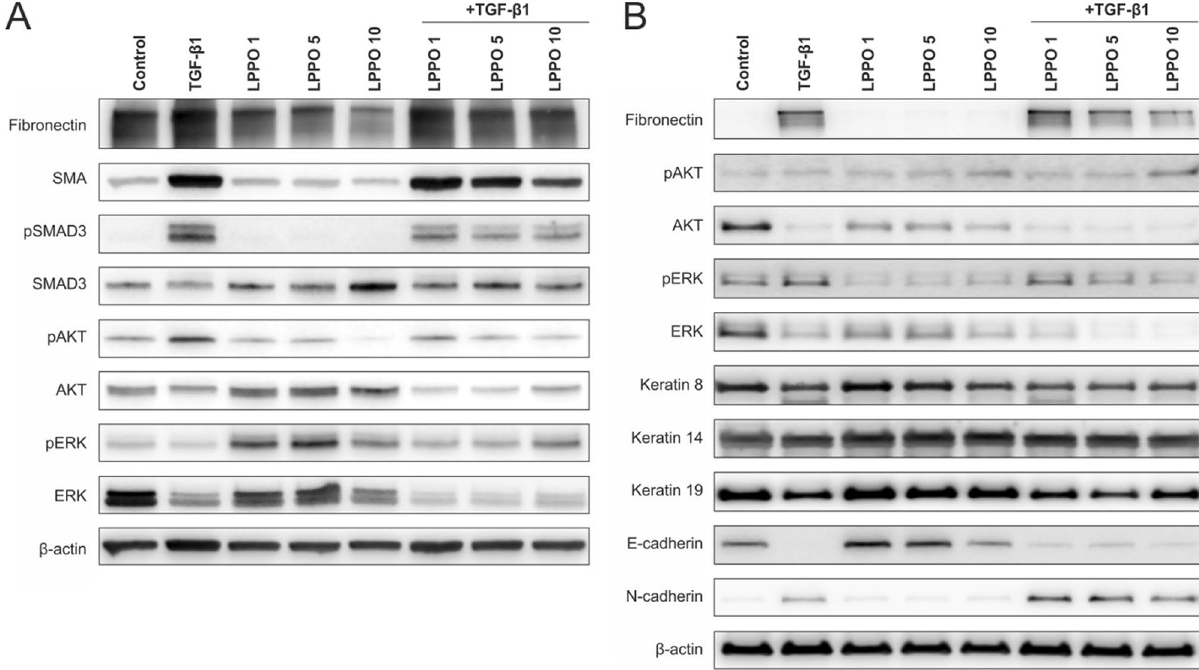
Figure 5. ( A ) Western blot analysis of LPPO and TGF-β1 30 ng/mL modulation of primary culture of human dermal fibroblasts (full-length gel is shown in Fig. S2). ( B ) Western blot analysis of LPPO and TGF-β1 (30 ng/ mL) modulation of human keratinocyte cell line HaCaT (full-length gel is shown in Fig.